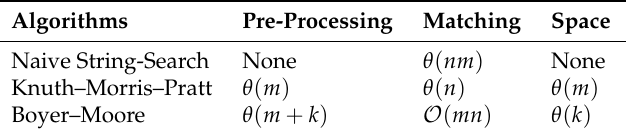
Table 4. Comparison of String-Matching